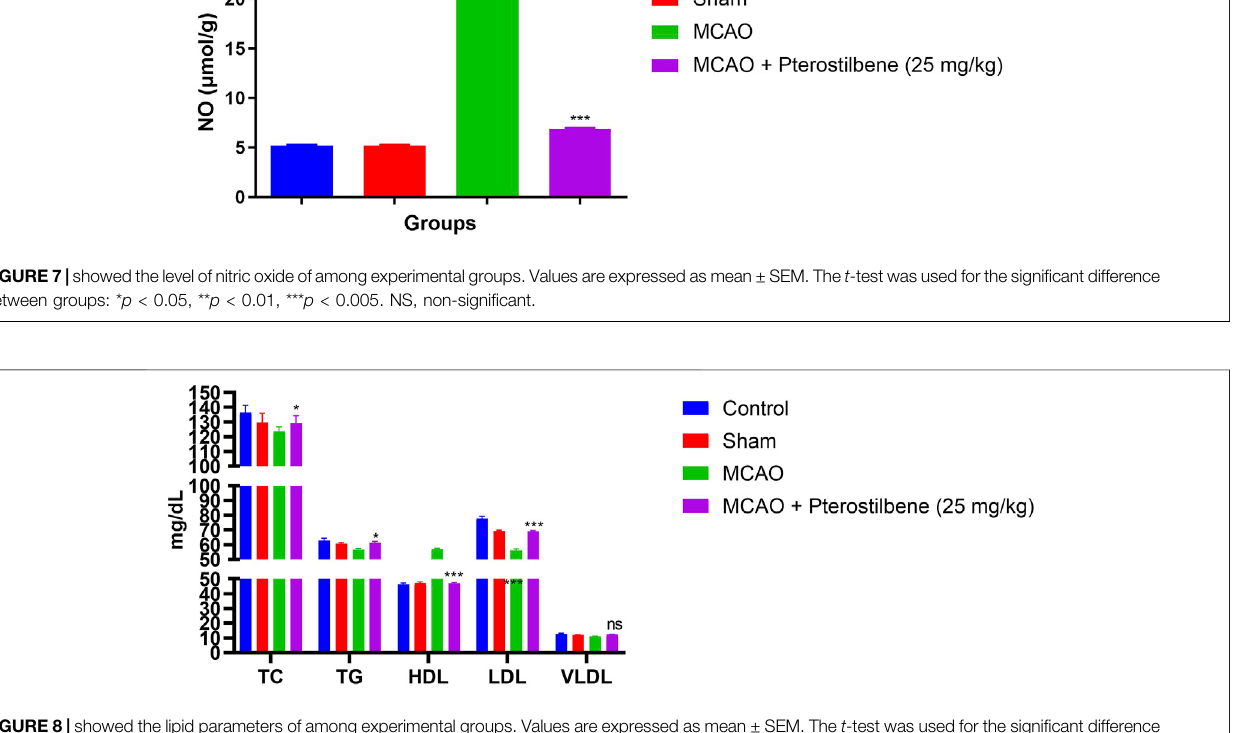
DISCUSSION Stroke and its related disorder cause the disability and death whole over the world. The loss of cerebral blood fl ow during an ischemic stroke causes metabolic, biochemical and hemodynamic